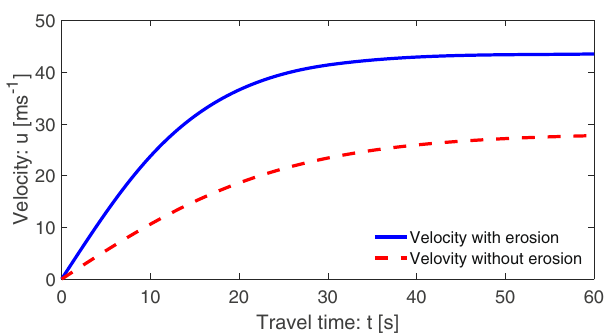
Fig. 2 Time evolution of velocity with and without erosion for dry landslide and erodible bed substrate given by (20). The landslide velocity, and thus its mobility, is largely enhanced by erosion.